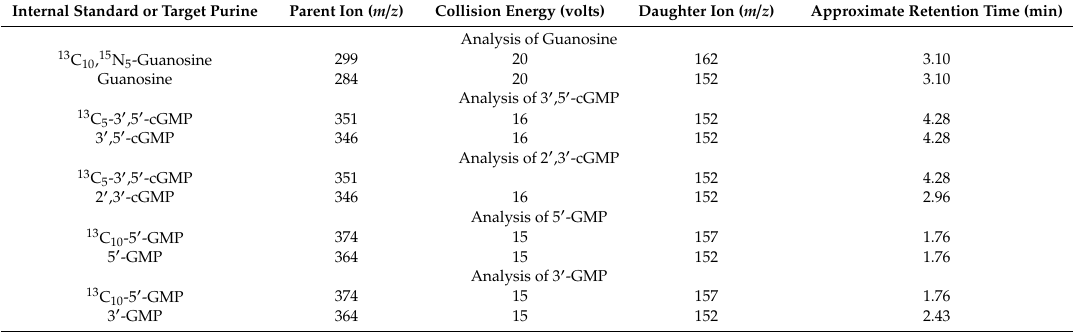
Table 2. Guanine Panel.